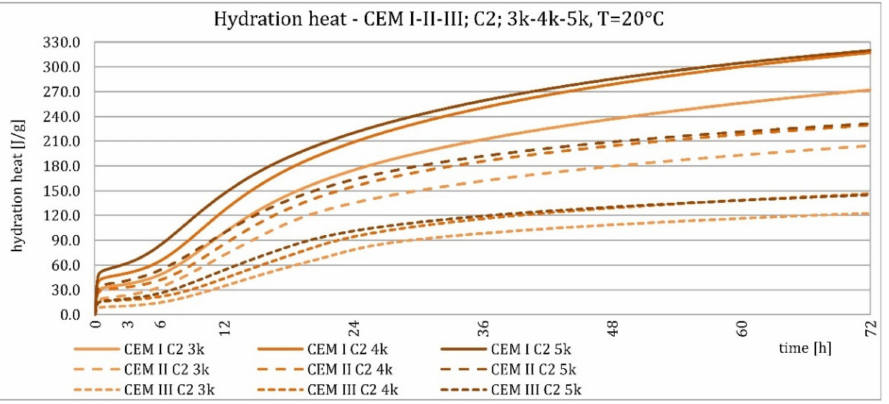
Figure 11. Hydration heat of C2 clinker based non-modified cements CEM I, CEM II/B-S, CEM III/A at 20 ◦